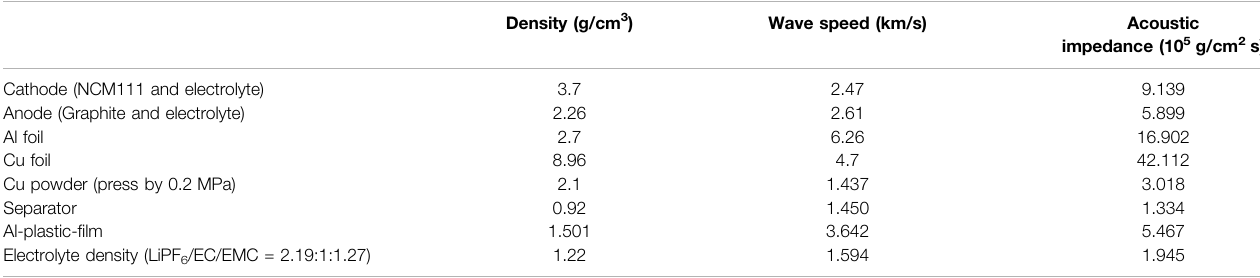
TABLE 2 | Acoustic properties of battery sample